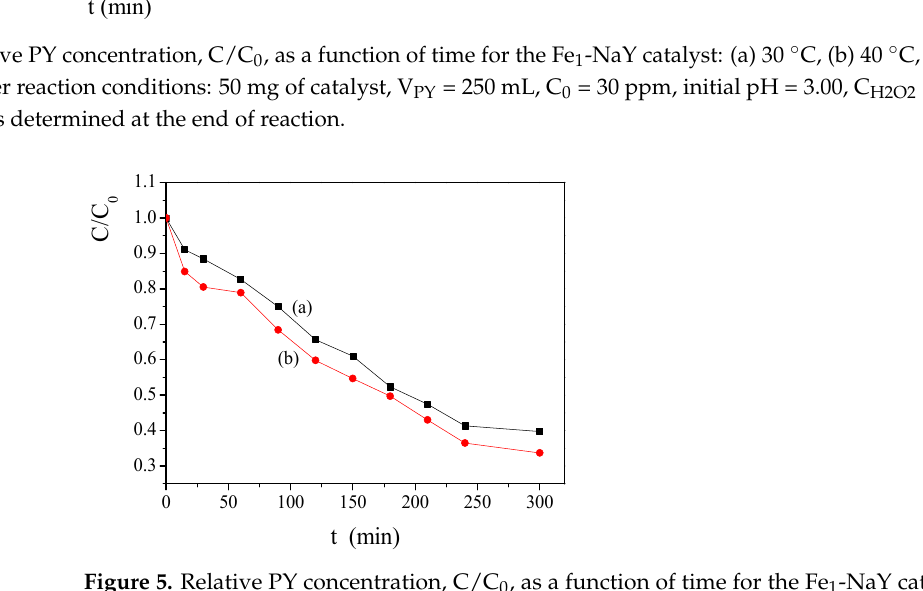
Figure 5. Relative PY concentration, C/C 0 , as a function of time for the Fe 1 -NaY catalyst at different H 2 O 2 concentrations: ( a ) 6 mM and ( b ) 12 mM. Other reaction conditions: 50 mg of catalyst, V PY = 250 mL, C 0 = 30 ppm, initial pH = 3.00, T R = 40 °C.